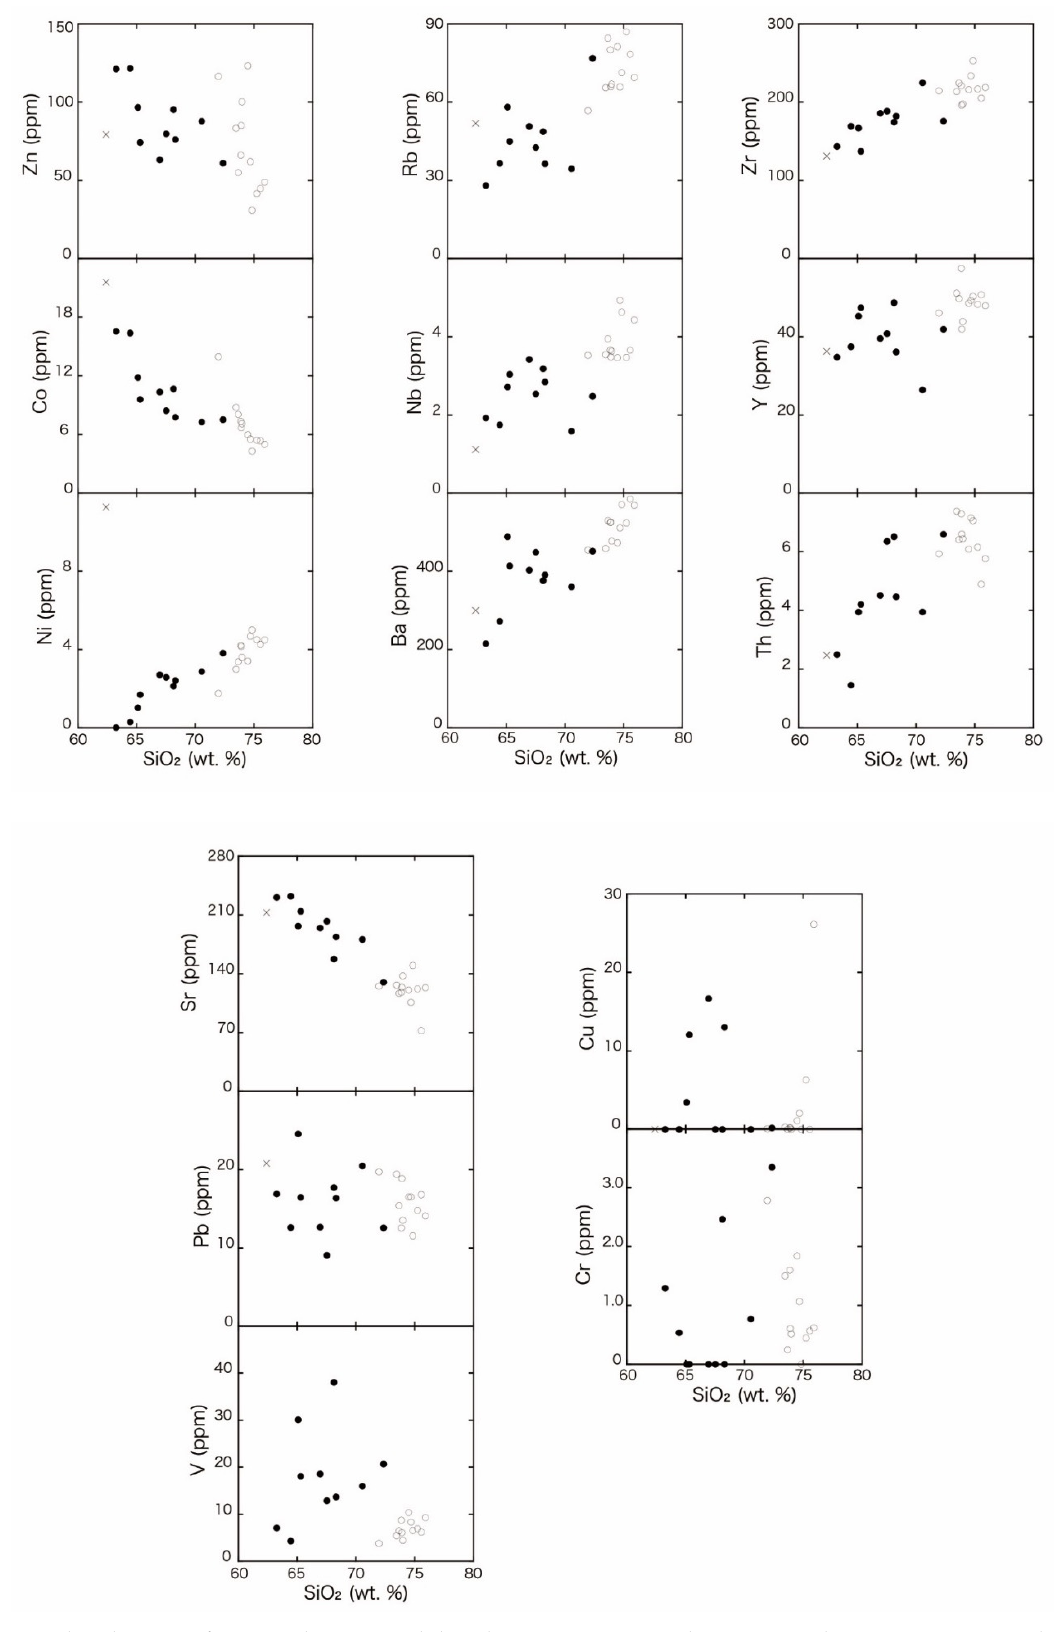
Figure 5. Harker diagrams for trace elements. Solid circle—GD group samples. Open circle—HFG group samples. Cross mark—dike sample. The plots of dike samples of GTA-2b and GTB-5b are out of range on this diagram.